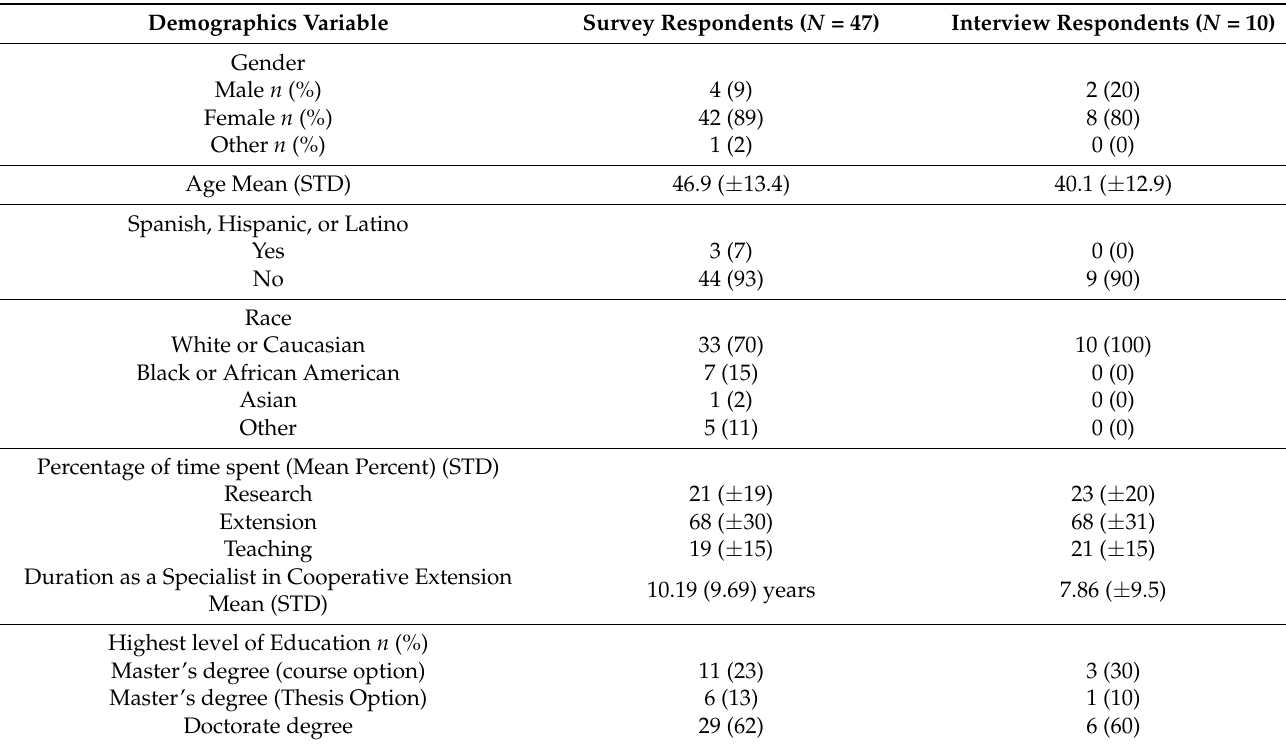
Table 1. Extension Specialist Demographics.